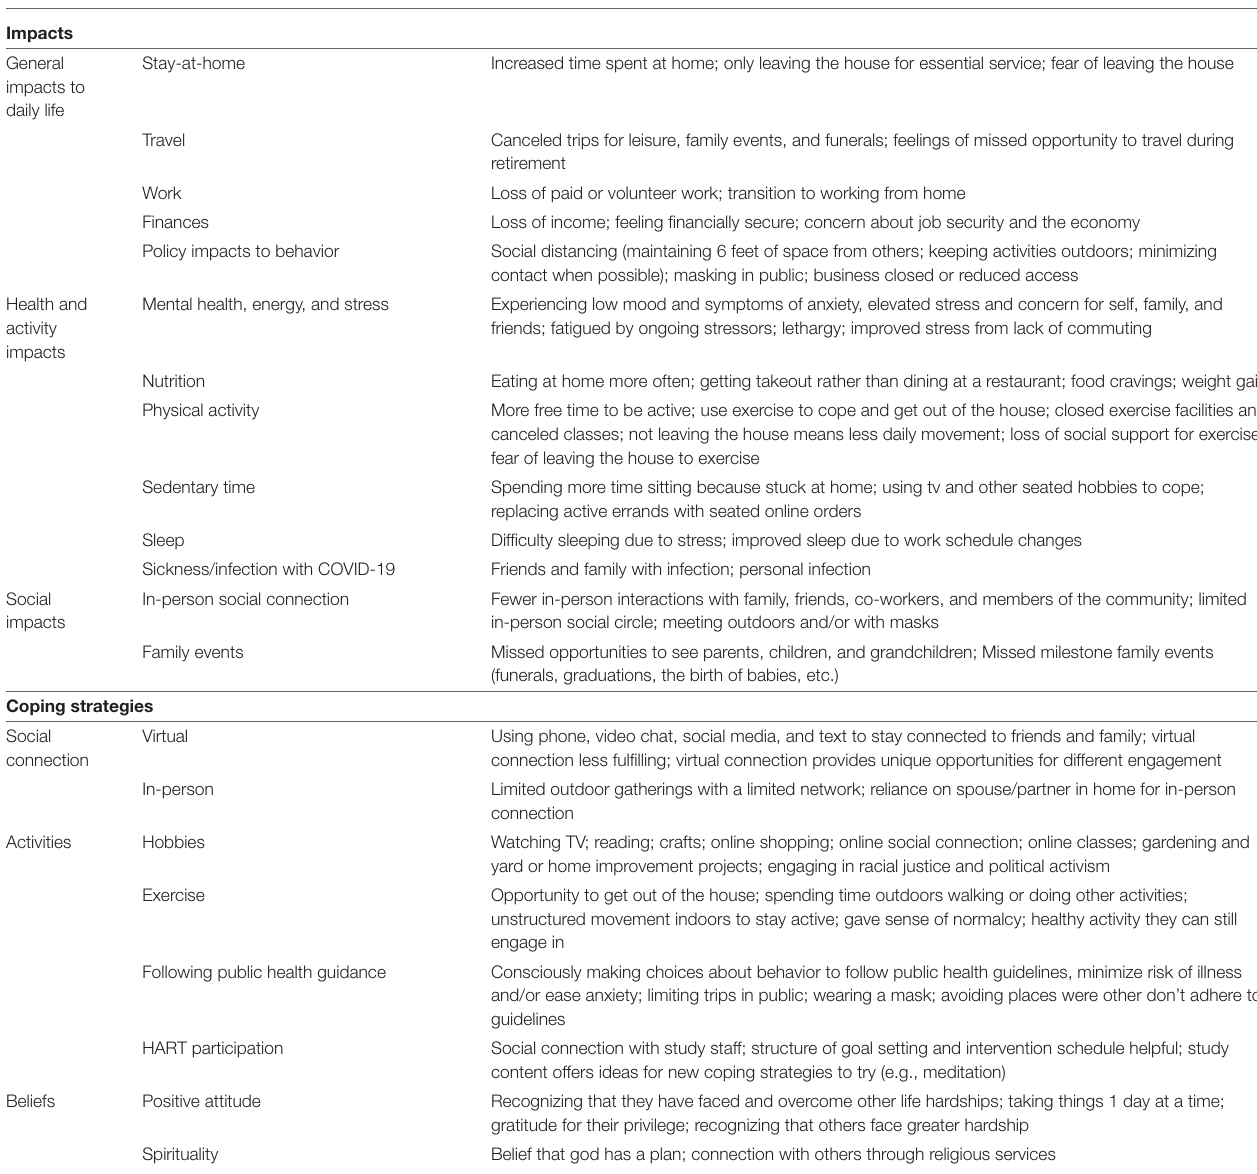
TABLE 2 | Summary of key themes. Domain Theme